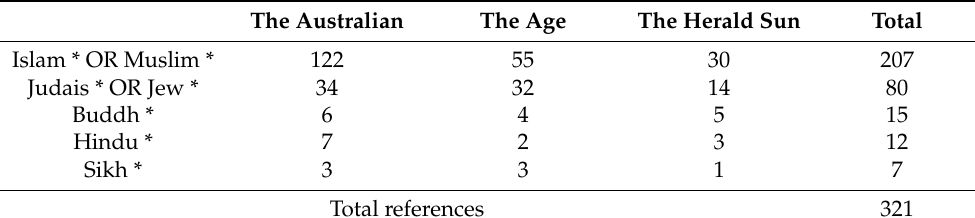
Table 8. Minority Religion references across the